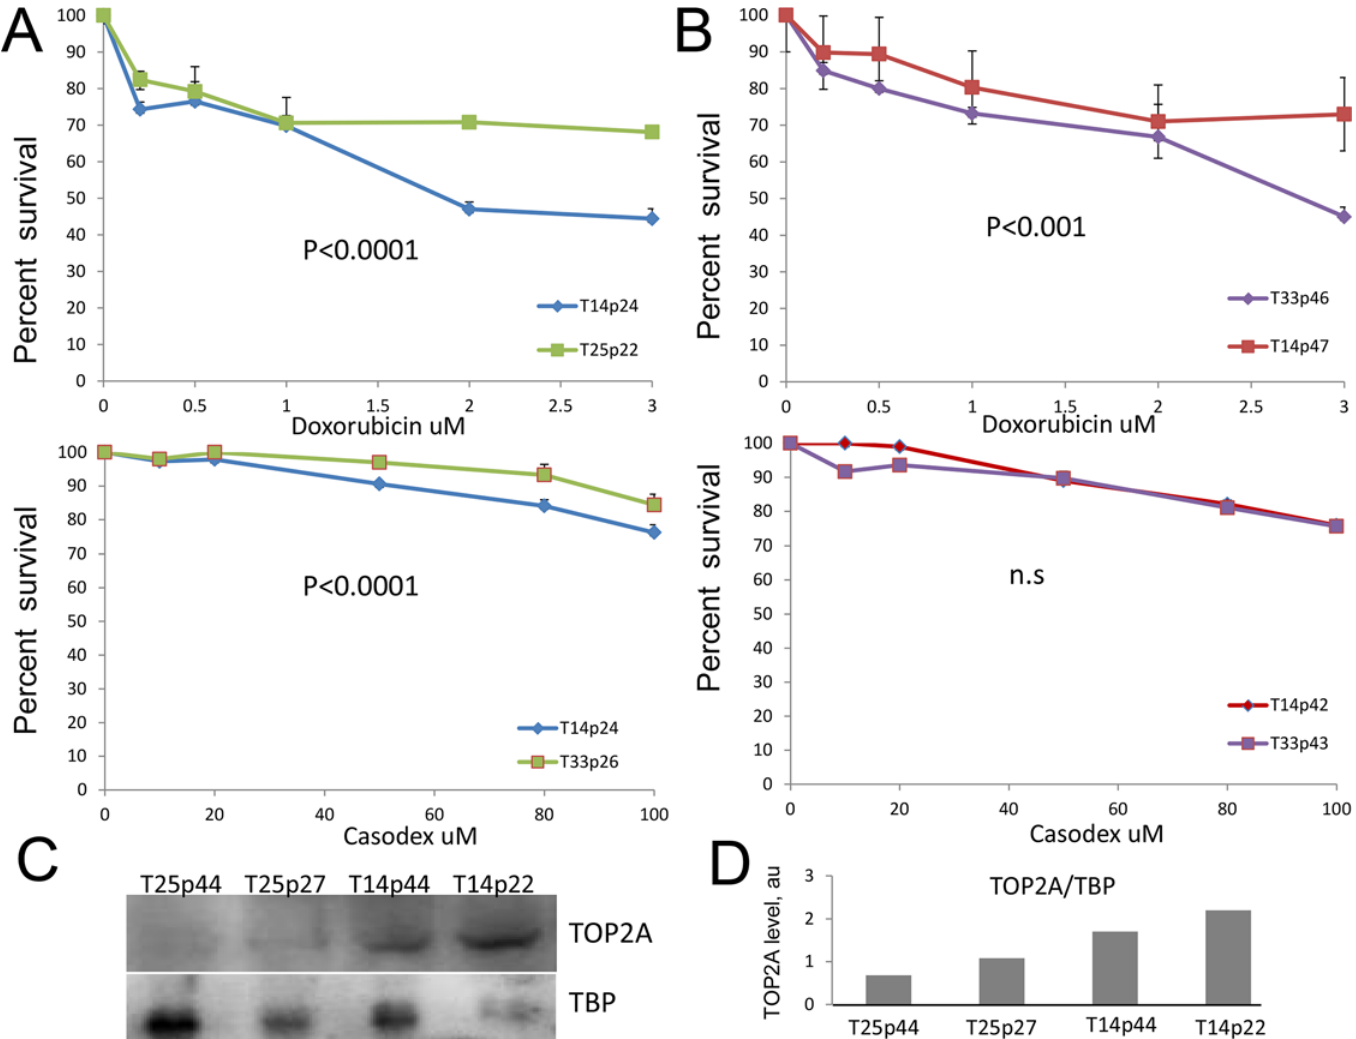
Fig 2. Sensitivity of TOP2A overexpressing to treatment with TOP2A poison and anti-androgen. A) Survival of TOP2A clones of early passage in response to treatment with doxorubicin (top panel) and casodex (bottom panel). B) Survival of TOP2A clones of late passage in response to treatment with doxorubicin (top panel) and casodex (bottom panel). C) Western blot showing levels of TOP2A in generated stable clones of early and late passages. Detection of nuclear protein TBP was used to verify equal loading. D) Quantification of TOP2A expression based on Western blot in C. Data are presented as mean ± SD, based on 3 independent experiments. P values are as indicated, n.s. is not significant.